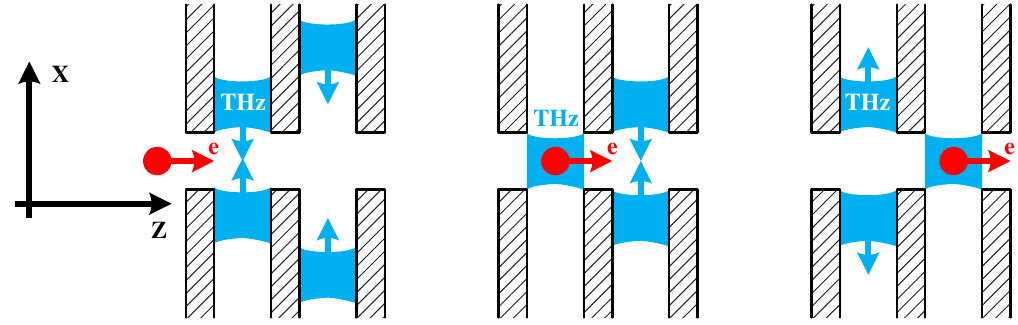
FIG. 2. Timing of THz pulses in the structure for acceleration